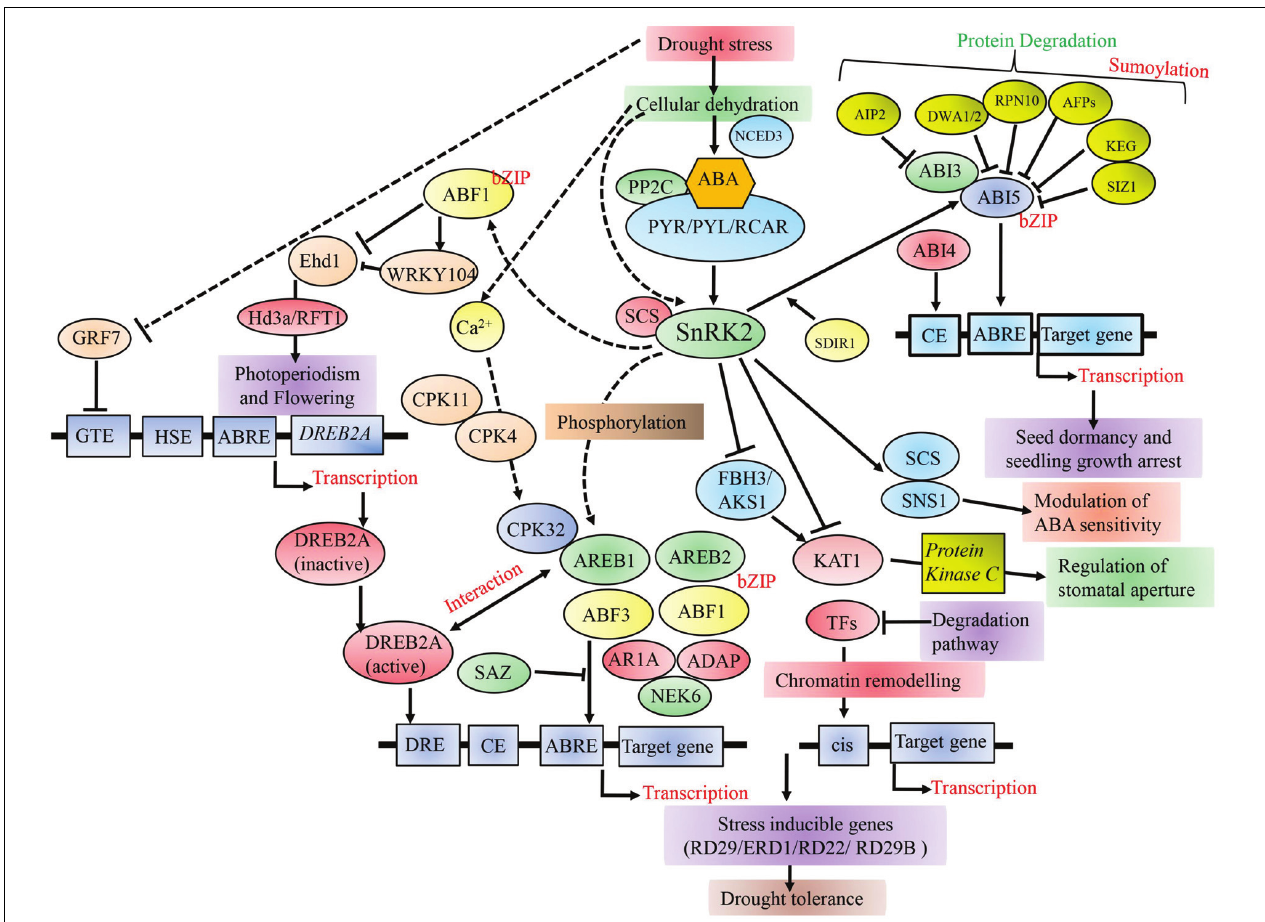
FIGURE 1 | A schematic model of the transcriptional regulation of different TFs playing key roles in cellular dehydration in plants. PP2C-PYR/PYL/RCAR complex positively regulates AREB/ABF-SnRK2 pathway. SnRK2s further modulate other TFs downstream including AREB/ABFs, FBH3/AKS1, and SNS1 during stress as well as seed maturation. Phosphorylated AREB/ABF TFs, AREB1, AREB2, ABF3, and ABF1 bind to the promoter region of target genes and activate their expression in response to dehydration stress. GRF7 suppresses the expression of DREB2A, which is a key TF in ABA-independent gene expression. Broken lines indicate possible roles. PP2C-PYR/PYL/RCAR, pyrabactin resistance1/PYR1-like/regulatory components of ABA receptors; PP2C, protein phosphatase 2C; CE, coupling element; GTE, GRF7-targeting cis element; HSE, heat shock element; TFs, transcription factors.